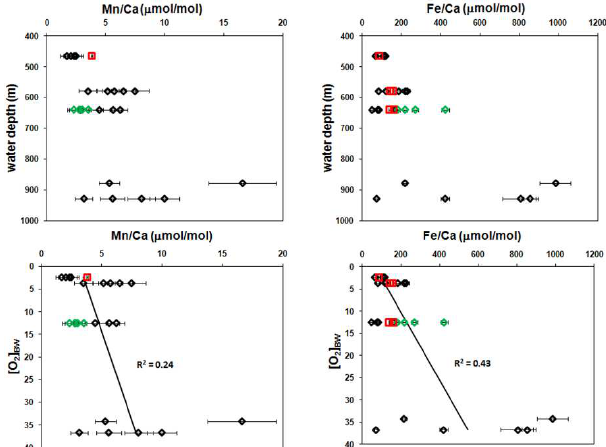
Fig. A2. Mn/Ca and Fe/Ca ratios in tests of Bolivina spissa plotted against water depth and [O 2 ] BW . All data points are plotted. Red squares indicate data points measured on bulk samples of 40 speci- mens with ICP-MS while diamonds indicate values from specimens measured with SIMS. The specimens indicated by the black dia- monds all have been treated with an oxidative cleaning procedure while the single green diamond represents an uncleaned specimen. Error bars show the analytical standard deviation of the